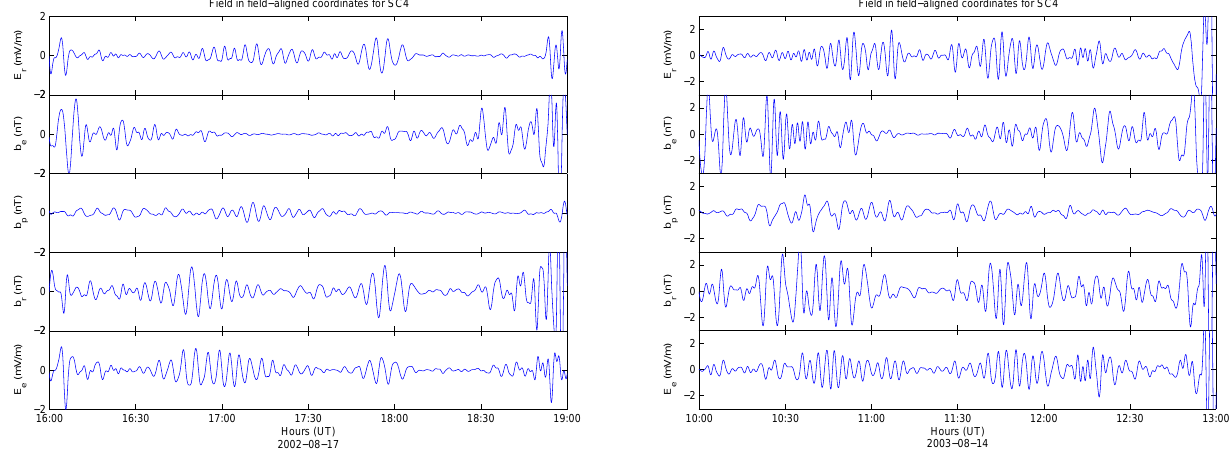
Fig. 7. As Fig. 5 but for the 14 August 2003